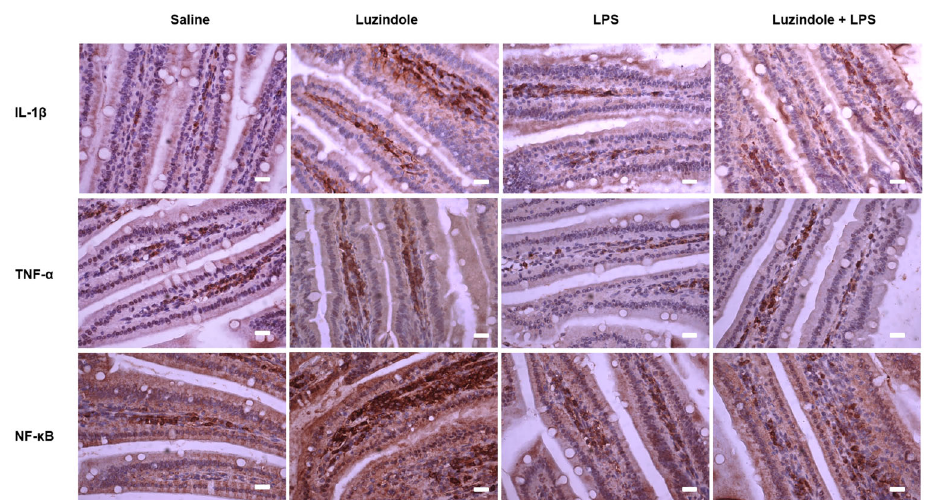
Figure 4. Jejunal interleukin (IL)-1 b , tumor necrosis factor (TNF)- a , and nuclear factor (NF)-kB immunolabeling (400 (cid:1) ) of Swiss mice receiving either saline (0.35 mg/kg, ip ), Luzindole (0.35 mg/kg, ip ), lipopolysaccharide (LPS) (1.25 mg/kg, ip ), or Luzindole + LPS (0.35 + 1.25 mg/kg, ip ). Scale bar=20 m m.